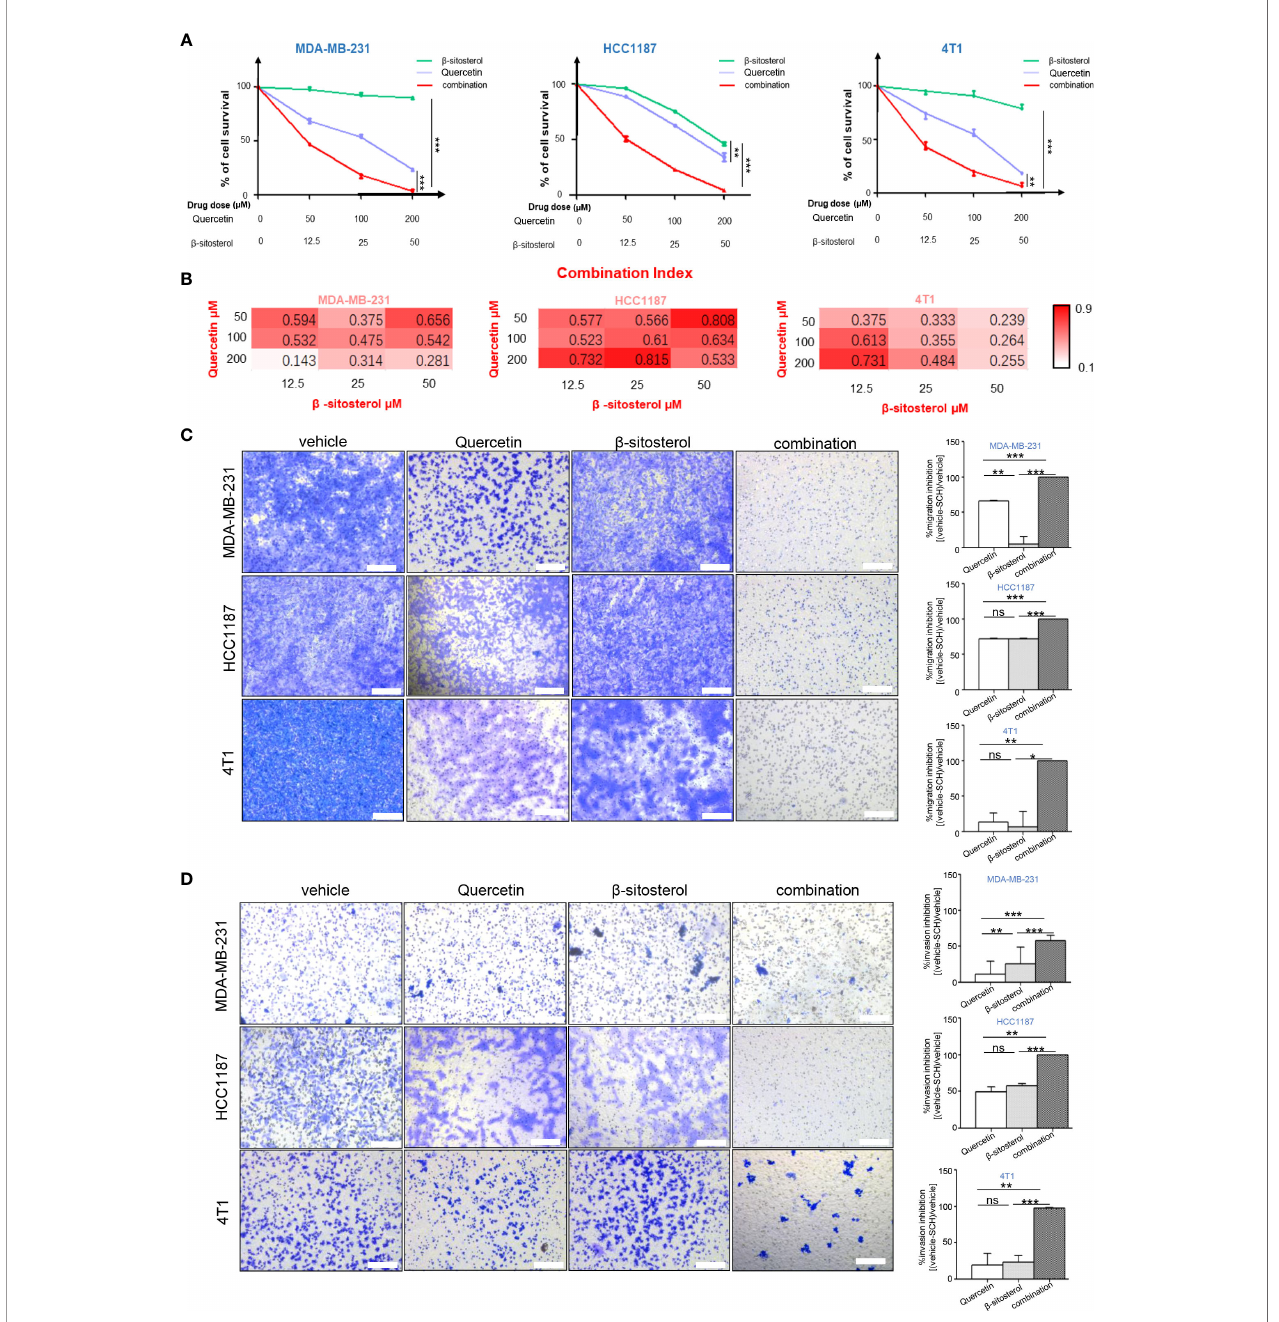
FIGURE 3 | Thecombinationofquercetinand b -sitosterolinducessynergisticgrowthinhibitoryeffectsonTNBCcells. (A) TNBCcellsweresimultaneouslytreatedwith quercetinand/or b -sitosterolfor48h.Cellviabilitywasmeasured via CCK-8assayanddepictedasthepercentageofviablecellsintheexperimentalgrouprelativetothaninthe controlgroup.Resultsarepresentedasmean±S.D.fromthreeseparatetrials. (B) Thecombinedeffectofquercetinandbeta-sitosterolwasgaugedwiththeaidofCalcuSyn software.Heatmapsdepictthecombinationindex(CI).Representativeimagesofthemigration (C) andinvasion (D) afterquercetinand/or b -sitosteroltreatmentwithTranswell assay.Scalebar,100µm.Resultsexhibitedasmean±S.D.fromthreeseparatetrials. “ ns, ” notsigni fi cant,*P<0.05,**P<0.01,***P<0.001(Student ’ s t